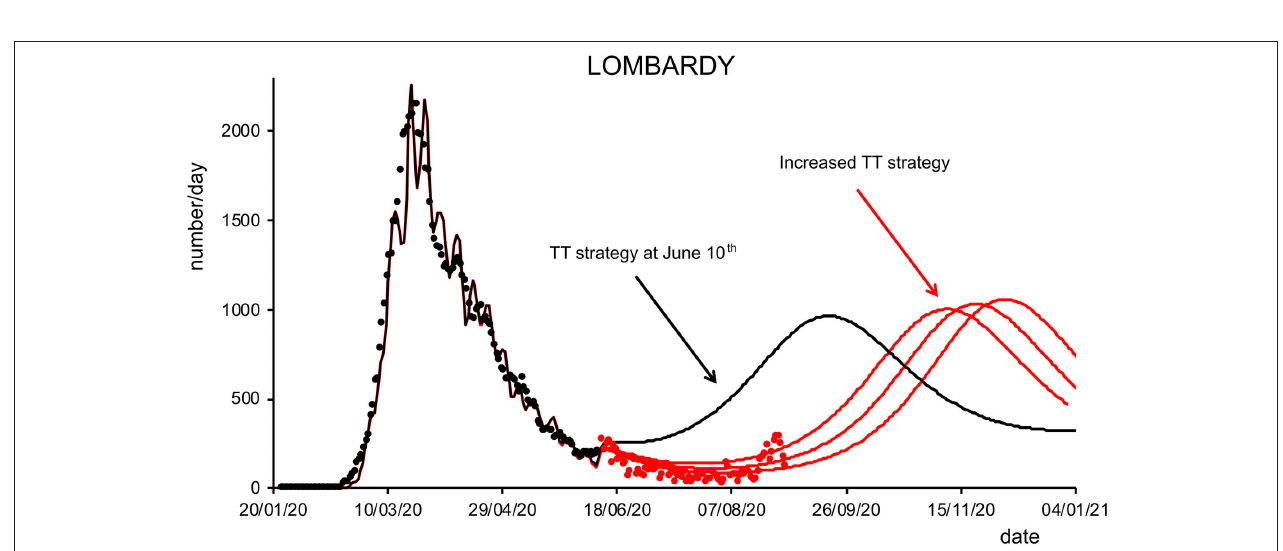
FIGURE 5 | Second-wave forecasts (Liguria, Piedmont, and Tuscany): The format of this figure follows that of Figure 4 .